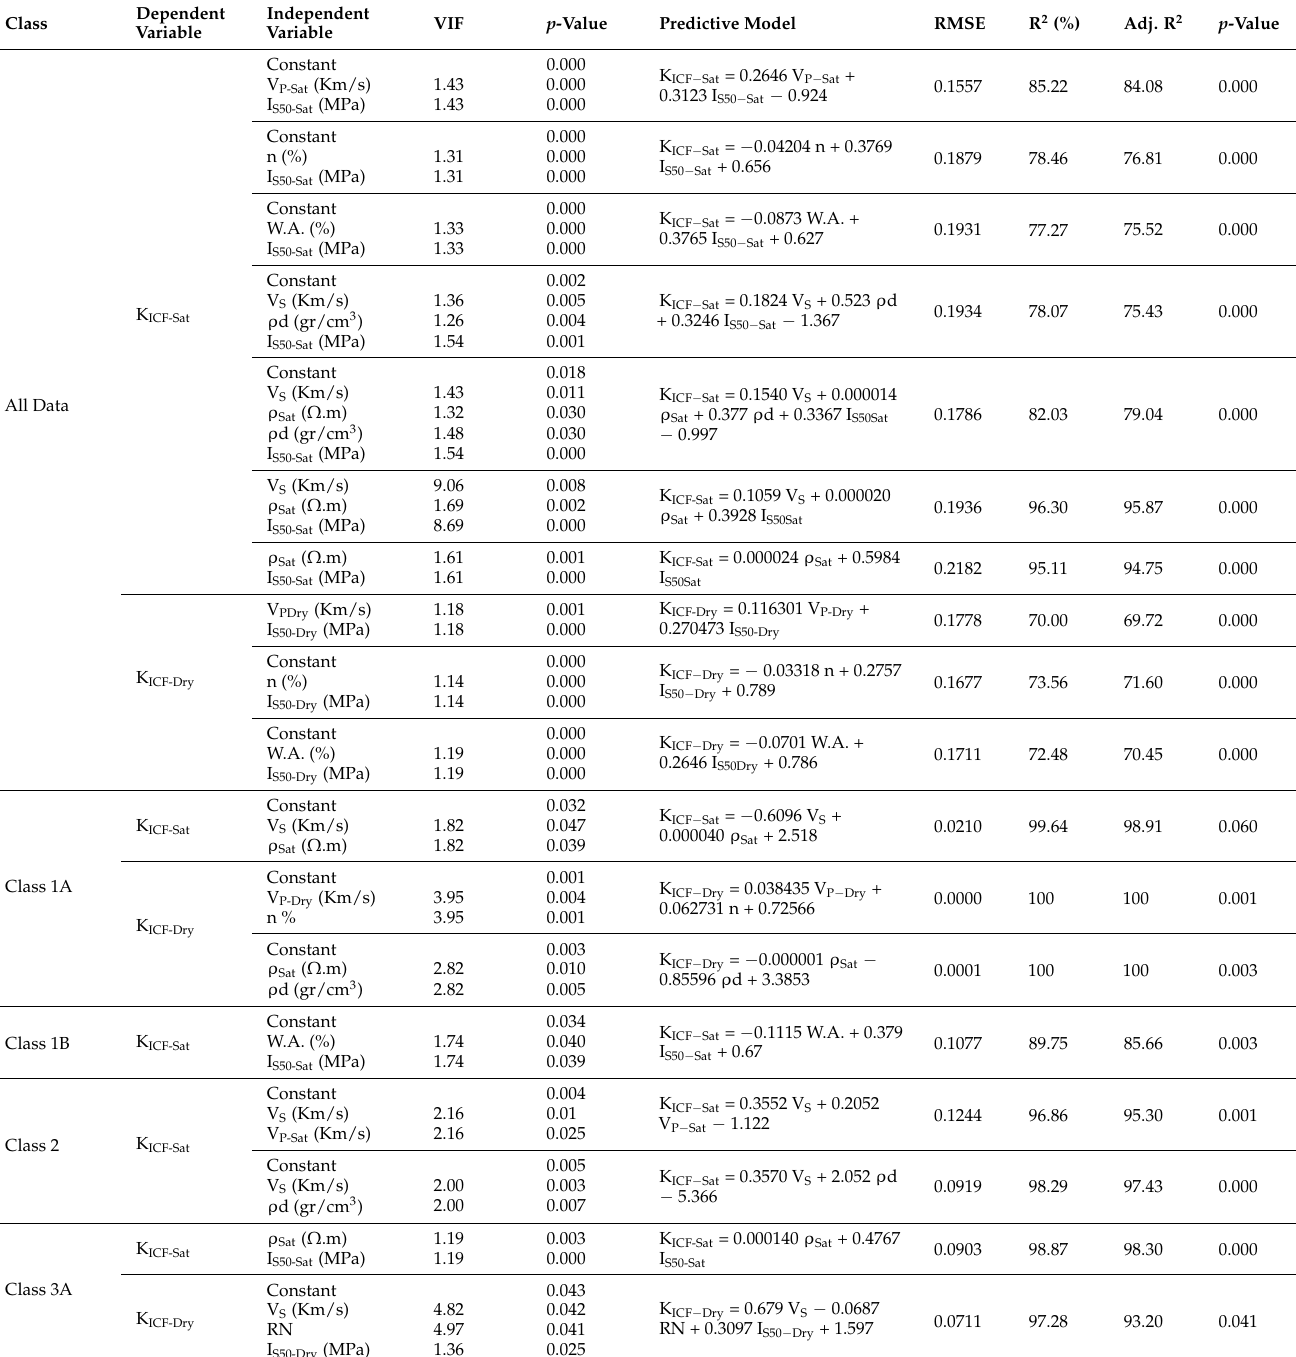
Table 9. Statistical parameters of the multiple linear regression between the K IC and index